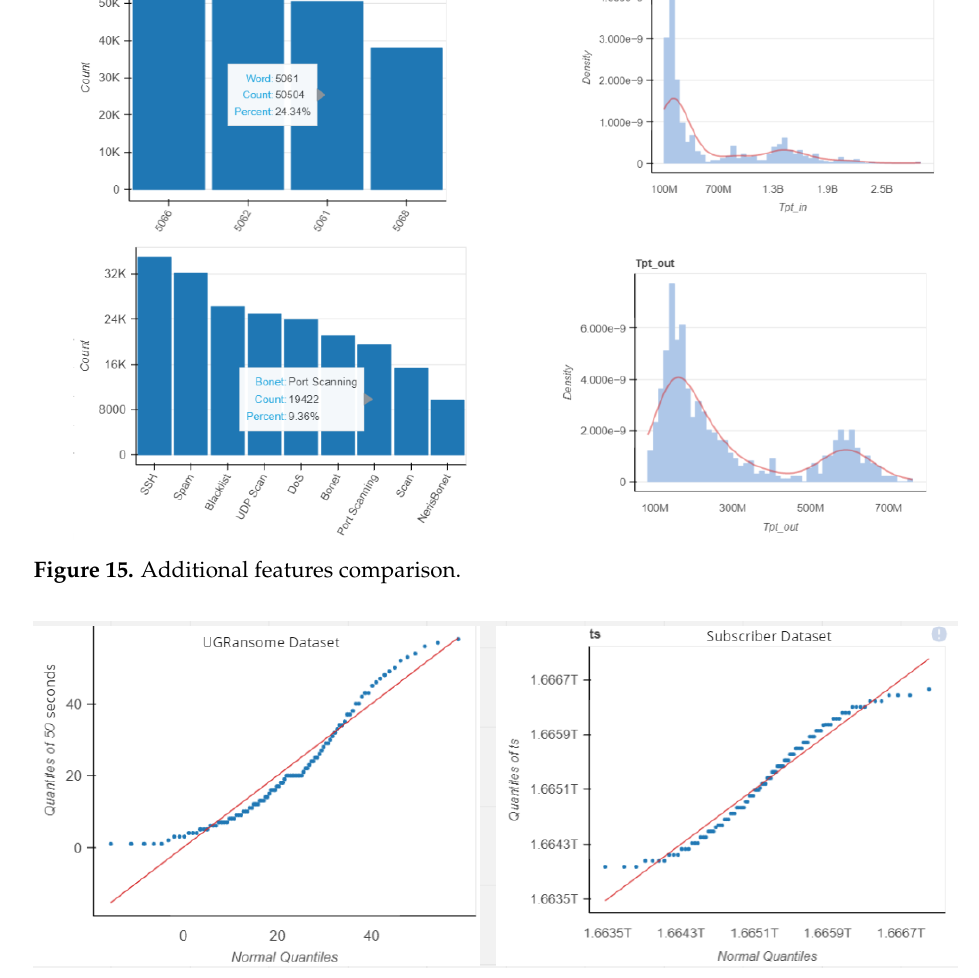
Figure 16. The normal Q-Q results. The correlation of throughput is in Figure 17.